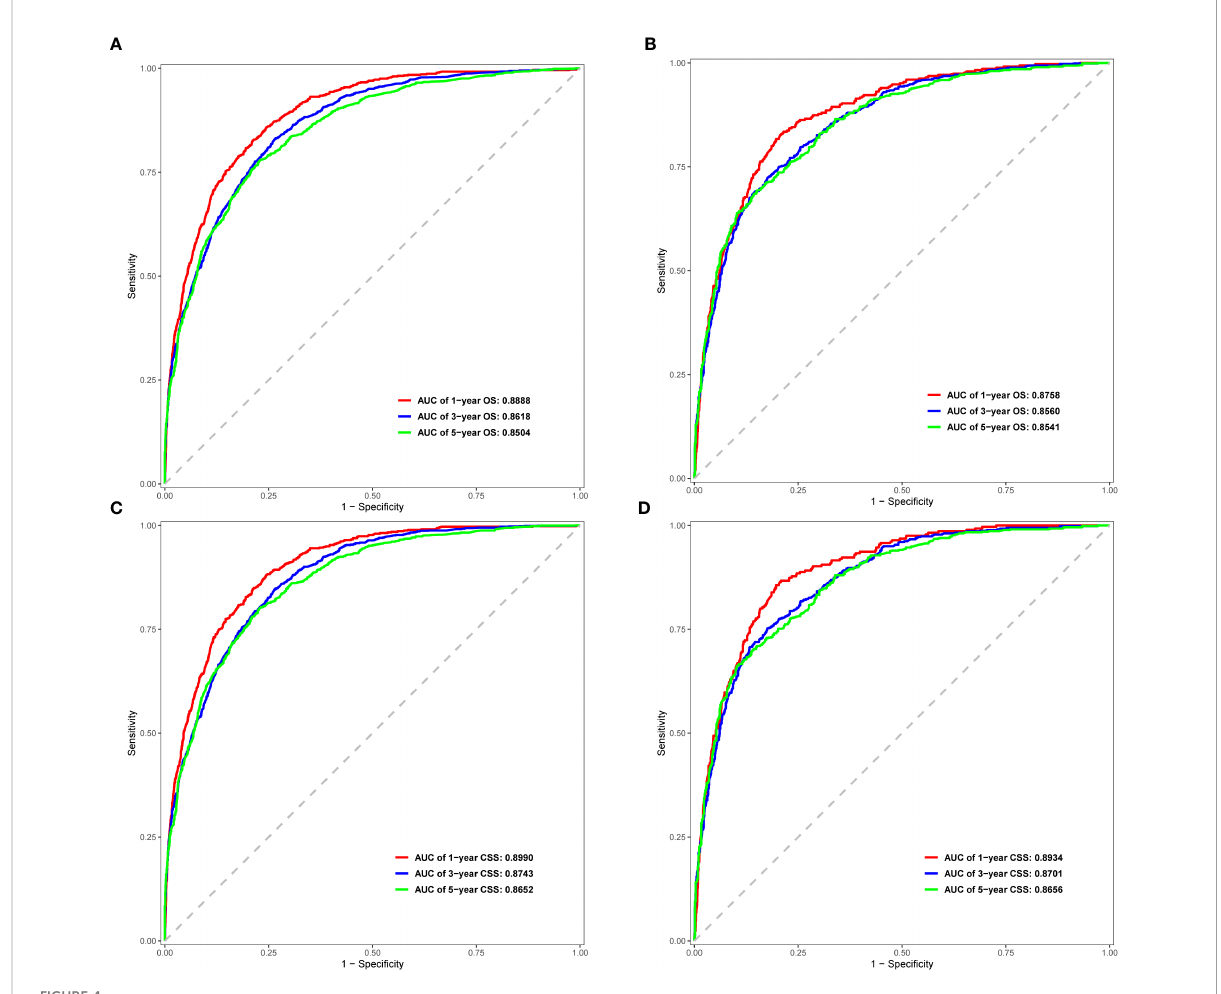
FIGURE 4 ROC curves for 1-, 3-, and 5-year OS and CSS in the training cohort (A, C) and validation cohort (B, D)